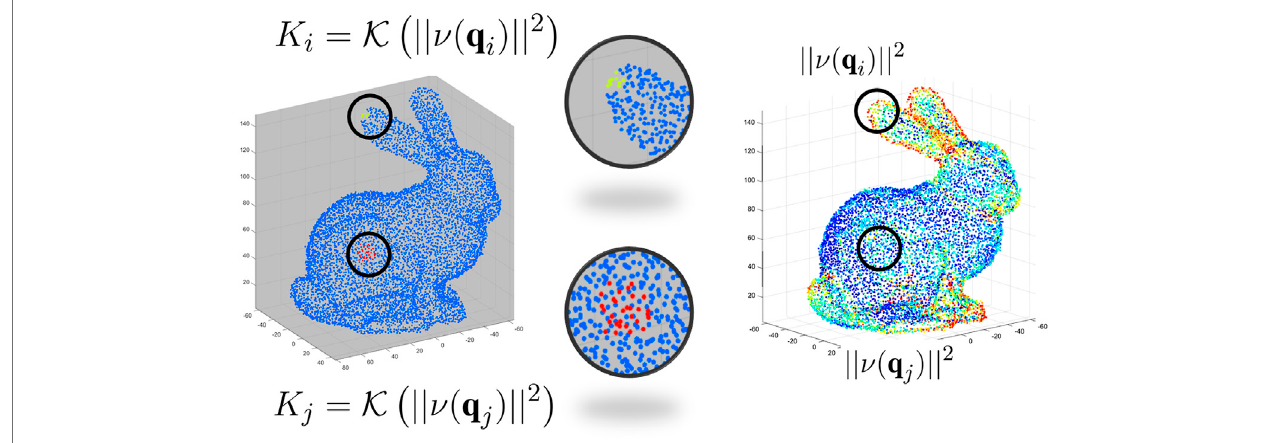
FIGURE 4 | Examples oftwo neighborhoods of different sizes K i and K j (left) around points characterized by different values ofthe mean square value of the MAHF output (cid:3) ν ( q i ) (cid:3) 2 (right). The considered point cloud is a low-resolution version of the Stanford bunny in Turk and Levoy 1994).